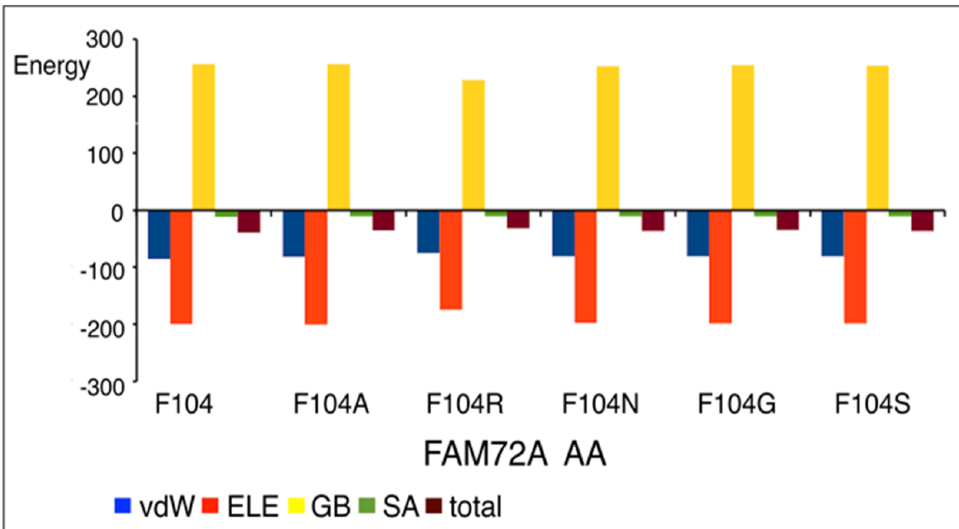
Figure 5. FWMF motif (AA101–104)-specific mutation-dependent FAM72A protein and UNG2 (AA1–45) peptide heterodimer free binding energy (energy in [kcal/mol]). FAM72A mutations at AA F104 phenylalanine (F104 → 104A, F104R, F104N, F104G, and F104S). A difference in total free binding energy was observed individually at the FWMF motif (AA101–104)-specific mutations, with F104R mutation showing the highest effect on energy-dependent conformational change affecting FAM72A-UNG2 binding. The FAM72A protein and UNG2 (AA1–45) peptide heterodimer free binding energy was calculated by the MM/GBSA approach. ELE, electrostatic; GB, polar accessible (a grid-based surface GB model is used for estimating the polar component of solvation free energy, coupled with water and atomic radii); SA, solvent area; total, sum of total energy; vdW, van der Waals; MM/GBSA, molecular mechanics/generalized Born surface area.